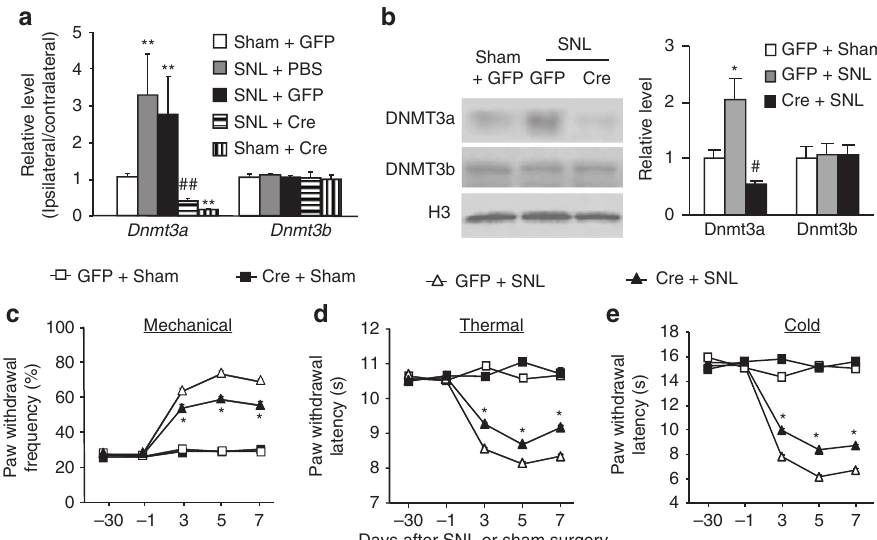
Figure 5 | DRG DNMT3a knockdown attenuates neuropathic pain development in mice. Cre: AAV5-Cre. GFP: AAV5-GFP. ( a ) Levels of Dnmt3a and Dnmt3b mRNAs in the ipsilateral L4 DRG on day 7 post-SNL or sham surgery from the Dnmt3a fl/fl mice injected with PBS, AAV5- Cre or AAV5- GFP . n ¼ 12 mice per group. One-way ANOVA followed by post hoc Tukey test, F group (4, 16) ¼ 5.45 for Dnmt3a mRNA and F group (4, 16) ¼ 0.15 for Dnmt3b mRNA. ** P o 0.01 versus the corresponding GFP plus sham group. ## P o 0.01 versus the corresponding PBS plus SNL group. ( b ) Levels of DNMT3a and DNMT3b proteins in the ipsilateral L4 DRG on day 7 post-SNL or sham surgery from the Dnmt3a fl/fl mice injected with AAV5- Cre or AAV5- GFP . n ¼ 12 mice per group. One-way ANOVA followed by post hoc Tukey test, F group (2, 8) ¼ 10.5 for DNMT3a protein and F group (2, 8) ¼ 0.05 for DNMT3b protein. * P o 0.05 versus the corresponding GFP plus sham group. # P o 0.05 versus the corresponding GFP plus SNL group. Full-length blots are presented in Supplementary Fig. 6. ( c – e ) The effect of microinjection of AAV5- Cre or AAV5- GFP into the ipsilateral L4 DRG of Dnmt3a fl/fl mice on paw withdrawal responses to mechanical ( c ), thermal ( d ) and cold ( e ) stimuli on the ipsilateral side at days shown before or after SNL or sham surgery. n ¼ 8 mice per group. Two-way ANOVA followed by post hoc Tukey test, F group (3, 129) ¼ 238.9 for ( c ), F group (3, 129) ¼ 357.9 for ( d ) and F group (3, 129) ¼ 367.9 for ( e ). * P o 0.05 versus the corresponding GFP plus SNL